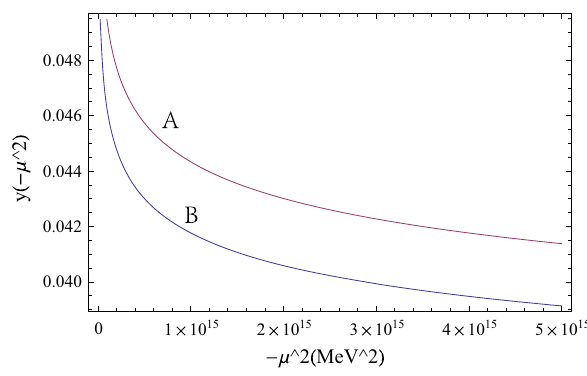
Fig. 2 The curves A and B are y an (μ 2 ) for Λ = 400 MeV and Λ = 200MeV, respectively